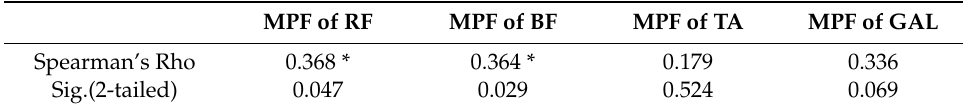
Table 4. The correlation between MPF and subjective fatigue (RPE) of each targeted muscle in the incremental load